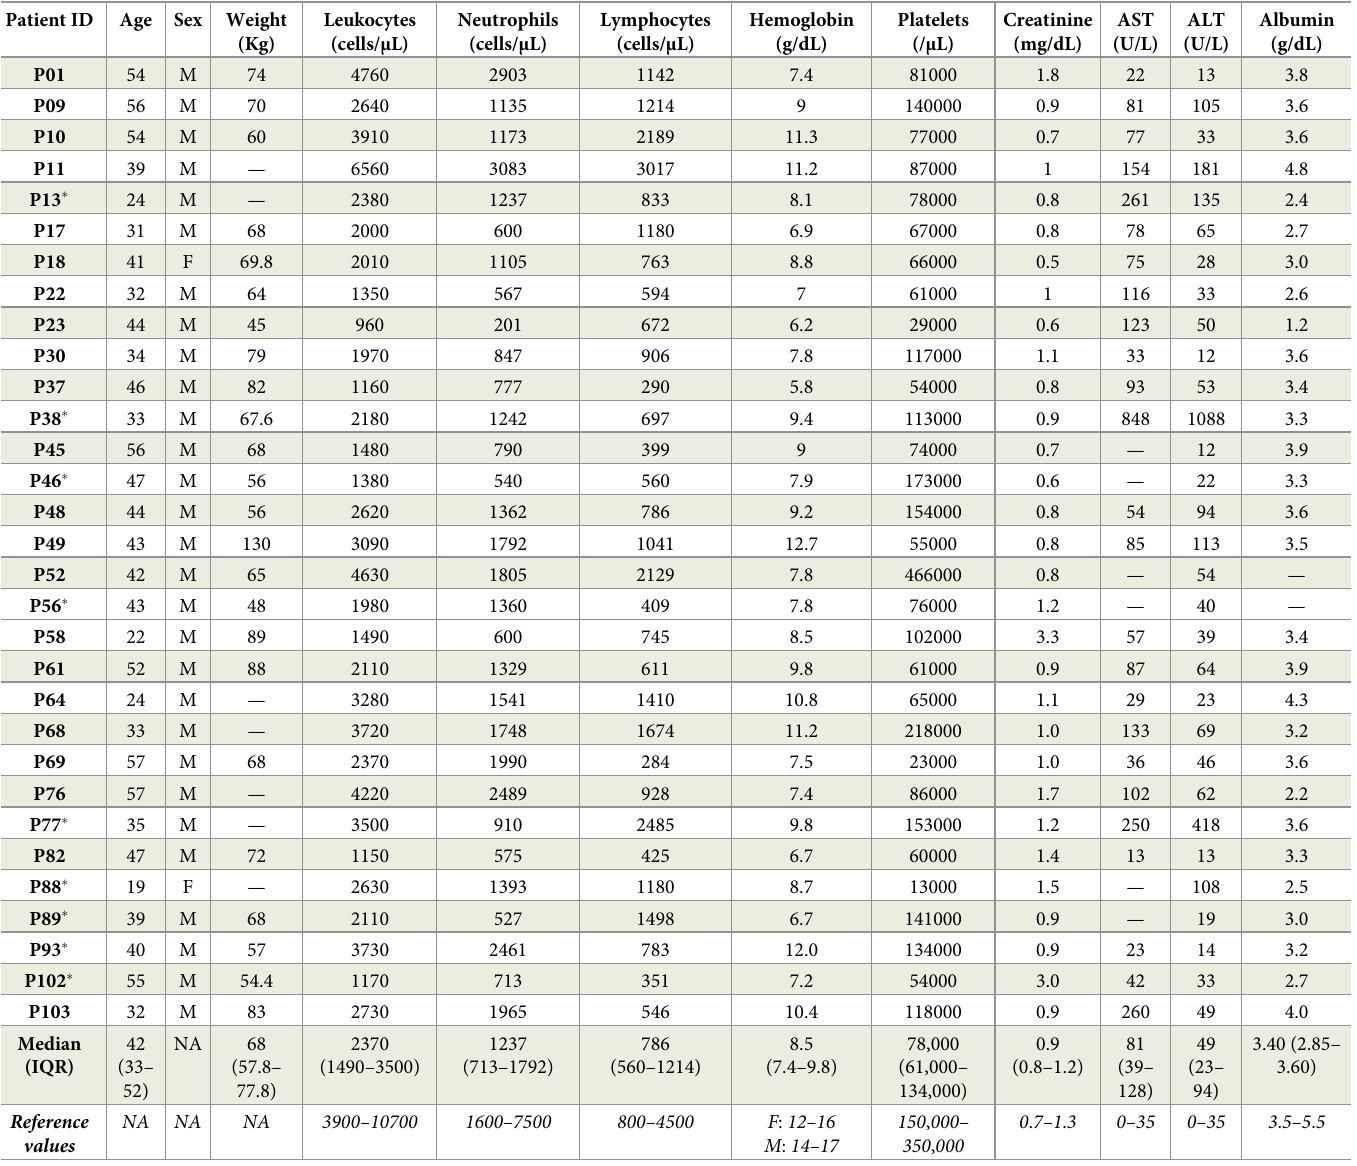
Table 1. Clinical characteristics of the visceral leishmaniasis patients in the active phase of